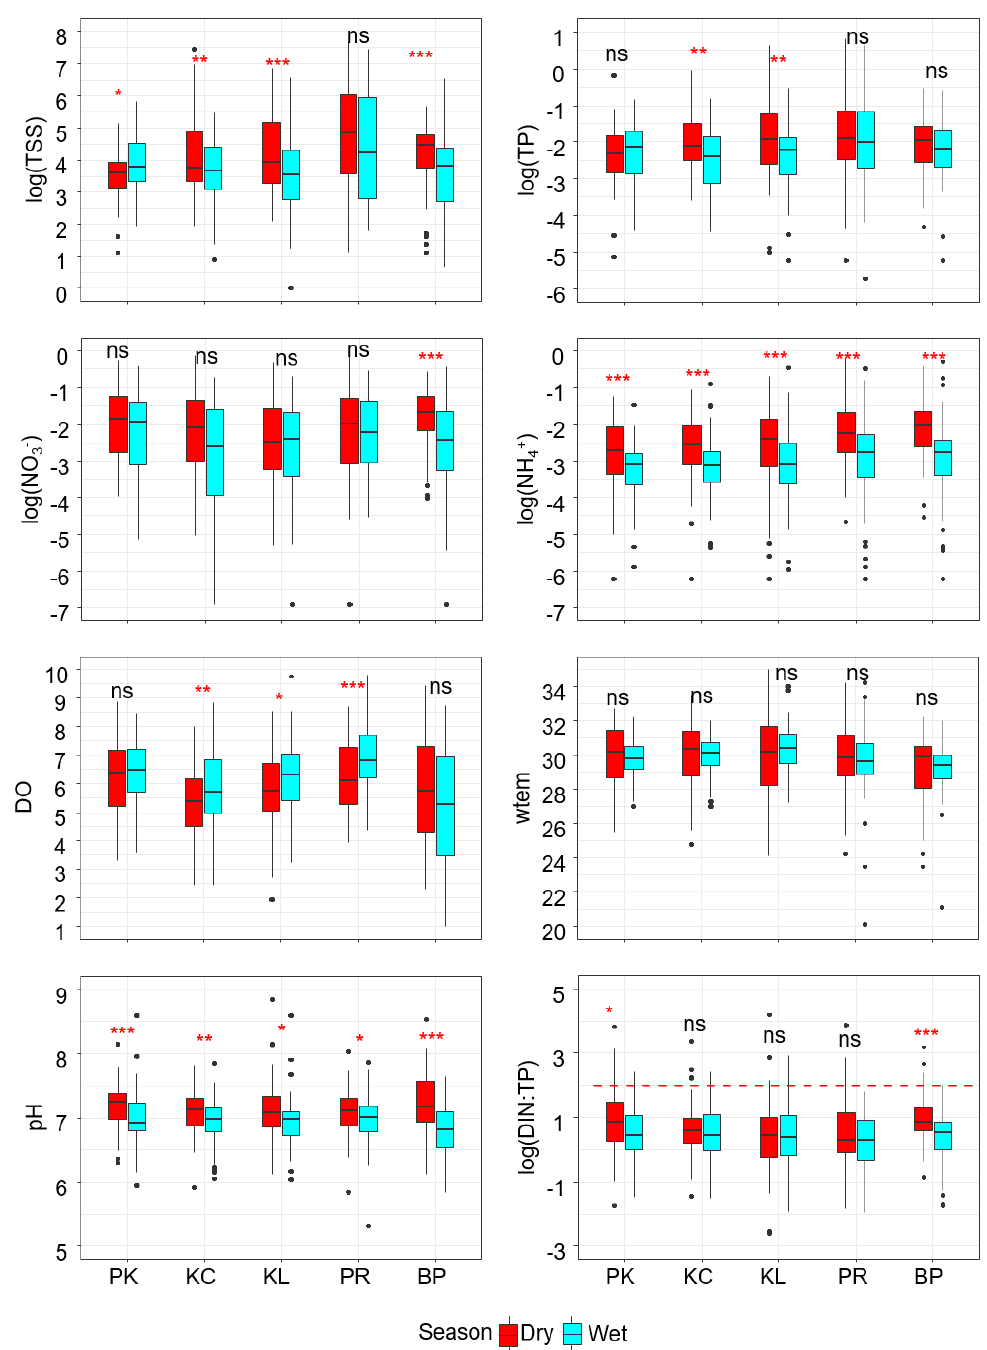
Figure 4. Wet versus dry season of water quality parameters by site in the Tonle Sap Ecosystem from 2005 to 2017. The significance levels are labeled as “ns” for a p -value > 0.05, * p -value ≤ 0.05, ** p -value ≤ 0.01, and *** p -value ≤ 0.001. The red dashed line indicates the ratio of DIN:TP at 7.2 by mass weight.